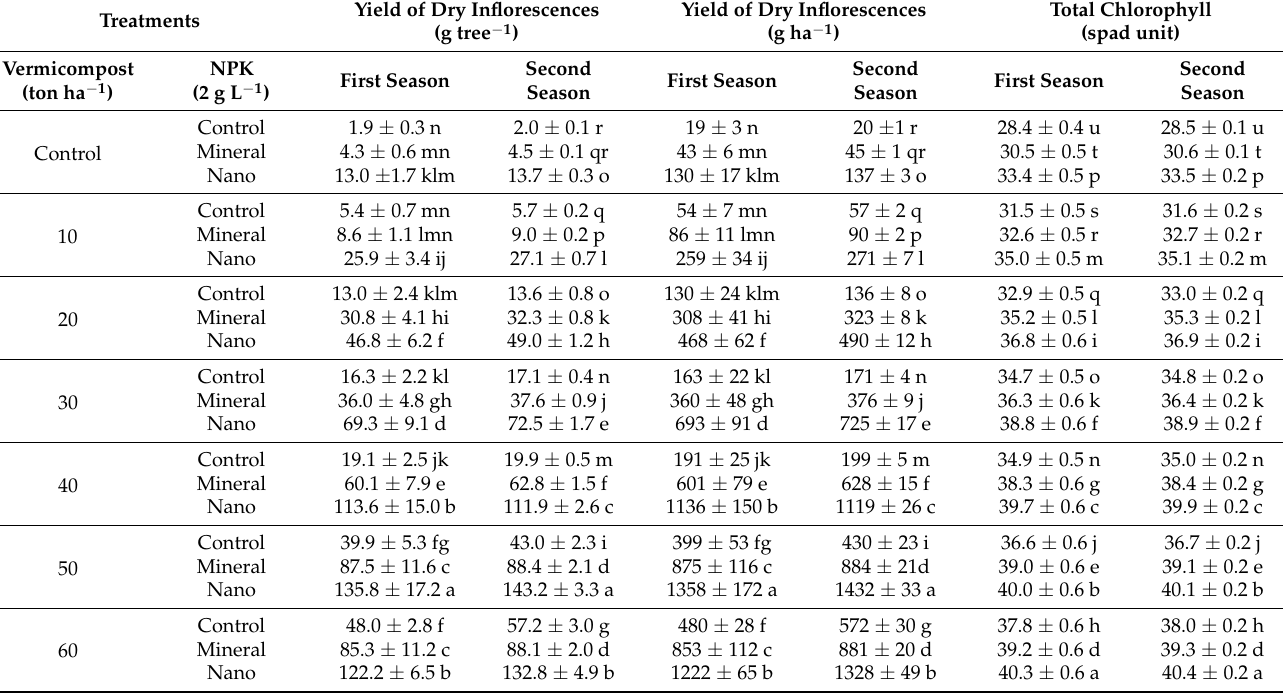
Table 6. The influence of combined treatments of vermicompost and NPK fertilization on the mean values of yield of dry inflorescences (g tree − 1 ), yield of dry inflorescences (kg ha − 1 ), and total chlorophyll (spad unit) of Moringa oleifera trees in the first and second seasons. Yield of Dry Inflorescences Yield of Dry Inflorescences Total Chlorophyll (g tree − 1 ) (g ha − 1 ) (spad